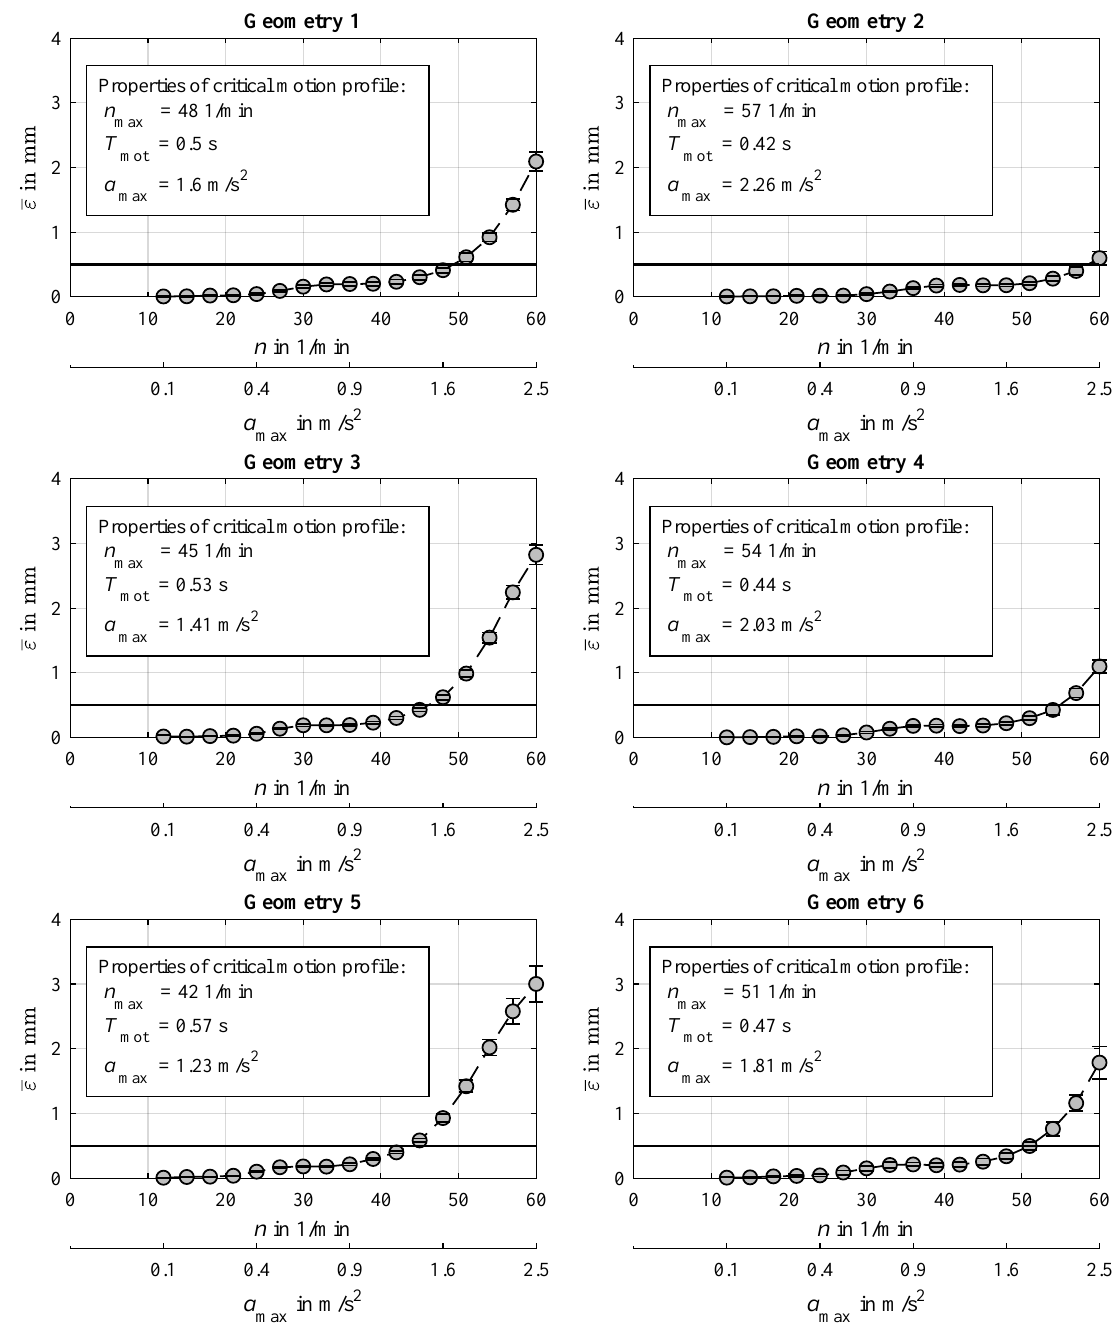
Figure 7. Mean errors of fluid’s surface line approximations for different geometries and operating speeds as well as the correspondent standard deviations. Assuming a tolerable error of 0.5mm, a maximum operating speed n max is derivable. Up to this operating speed, the considered fluid’s surface motion can be described as a line, and thus can be used for the pendulum